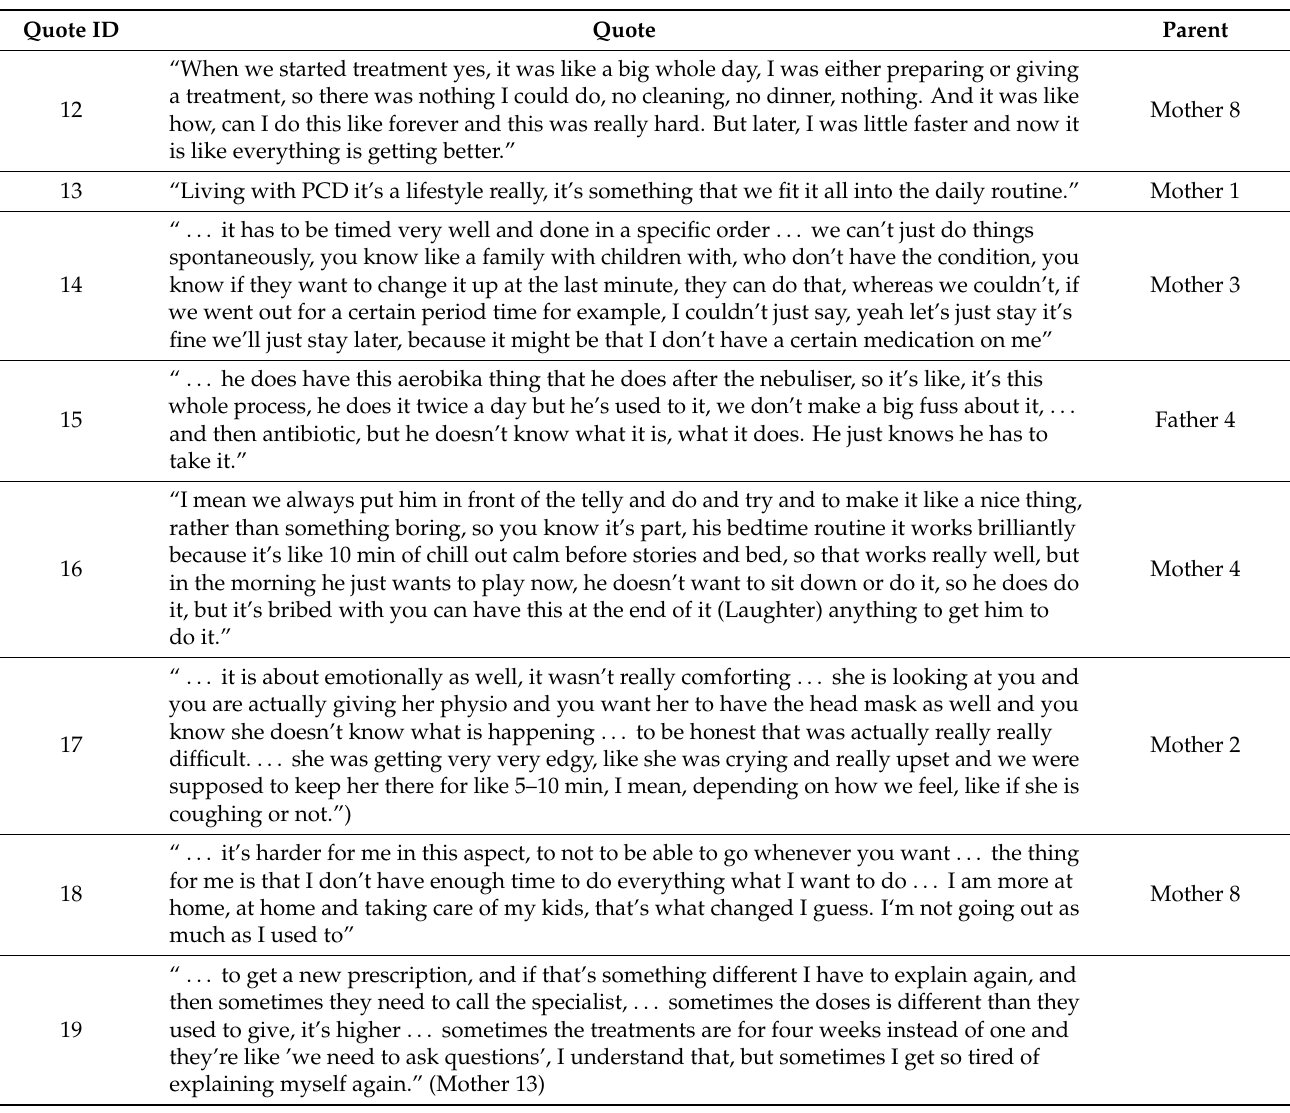
Table 4. Quotes from parents on the impact of the PCD treatment